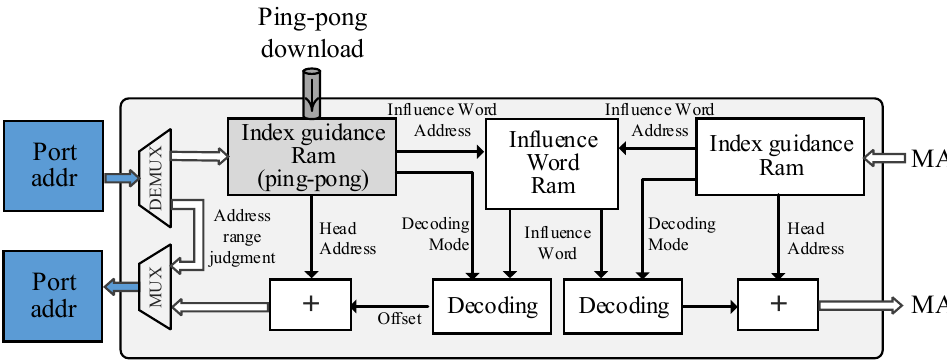
Figure 10. Hybrid architecture indexing unit.